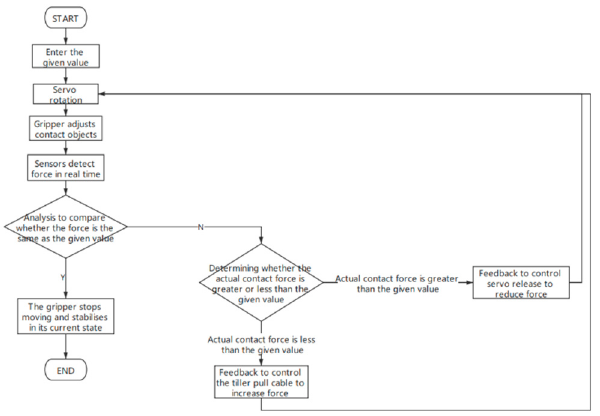
Figure 6. Workflow diagram of the proposed soft robotic gripper with force feedback function.